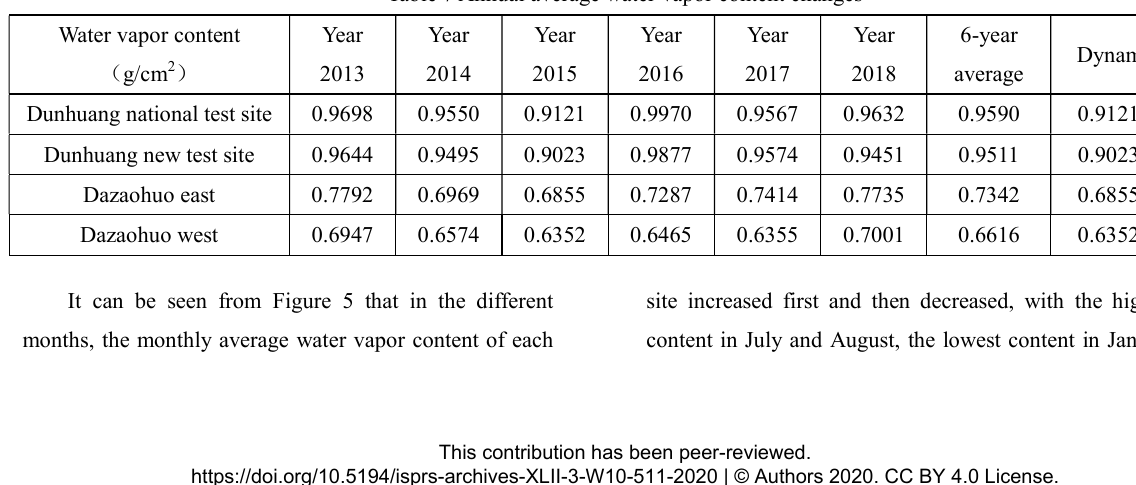
Figure 5. Monthly average water vapor content changes Table 7 Annual average water vapor content